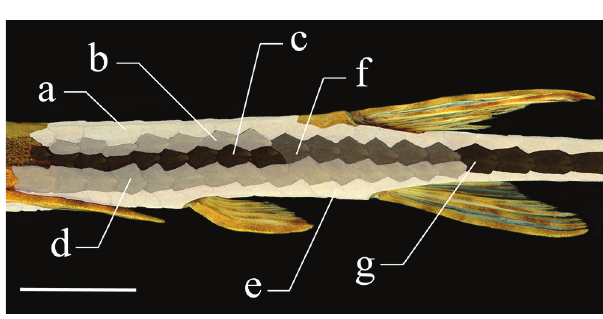
Fig. 1. Lateral plate series in Farlowella gianetii (holotype, MZUSP 95564, 115.6 mm SL). Each color represents individual series or fusions referred in the text. Plate series as follows: a) dorsal, b) dorsomedian, c) median, d) ventromedian, e) ventral, f) dorsomedian+median, g) coalescent series (dorsomedian+median+ventromedian). Scale bar: 1 cm.